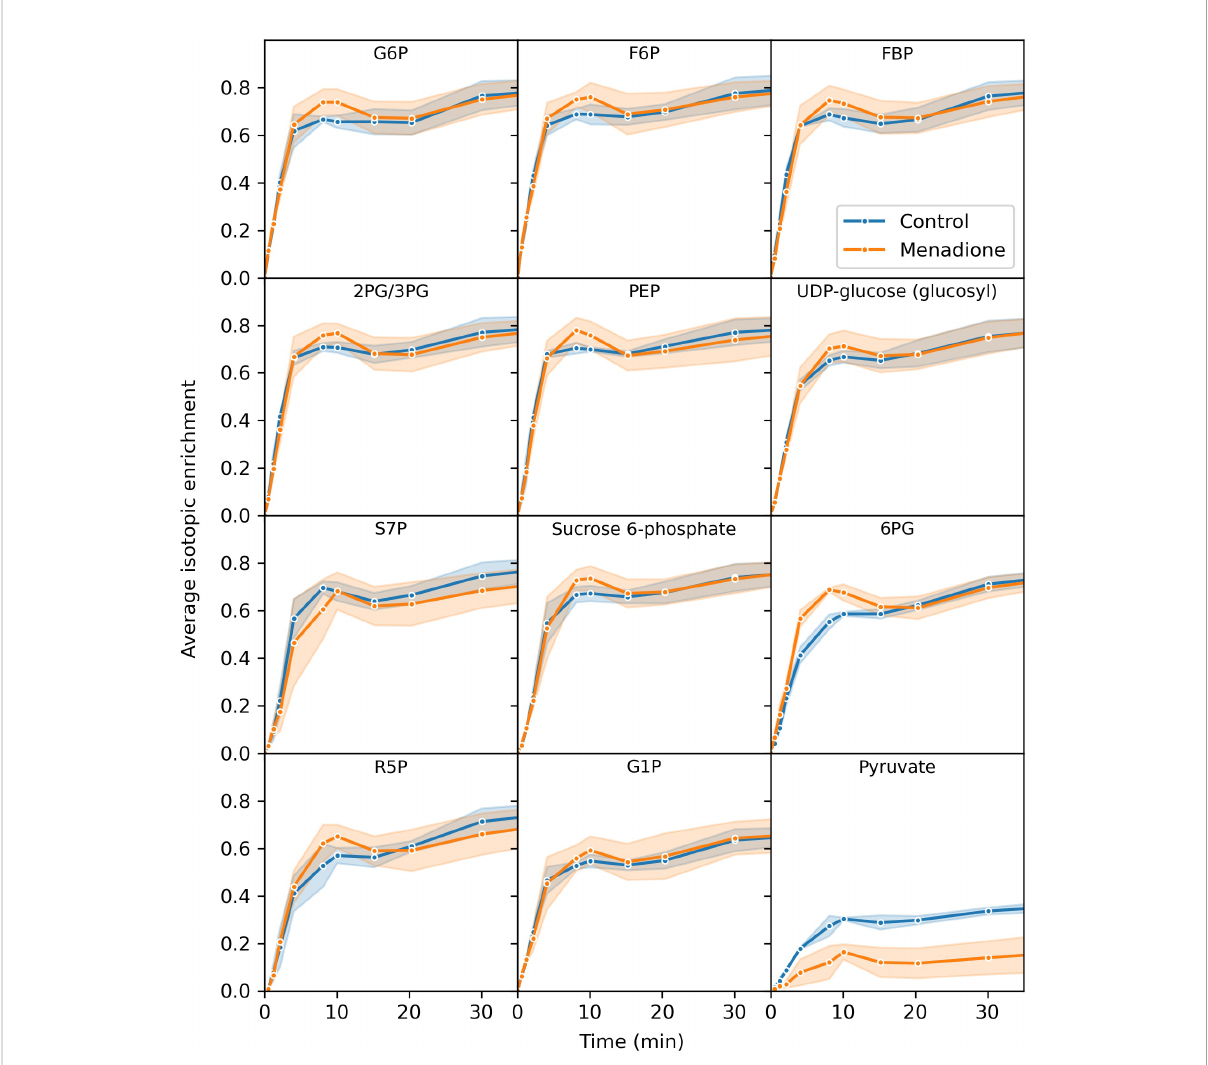
FIGURE 2 Average isotopic enrichment of glycolytic, pentose phosphate pathway and starch/sucrose synthesis intermediates after supply of [ 13 C 6 ]glucose to heterotrophic arabidopsis cell cultures following 6 h treatment with 60 µM menadione or untreated control. Isotopic enrichment is corrected for natural abundance of heavy isotopes and the proportion of labelled substrate in the media. Values are the mean ± SD (shaded region), n =